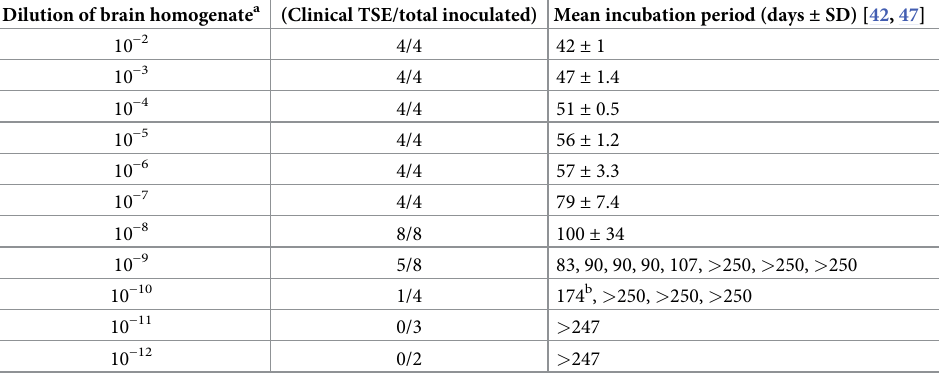
The incubation period to terminal disease was about 174 days at the end-point. An approximate linear regression curve (y = 10.6–0.105x; r = 0.87) was calculated from the mean incubation periods of dilutions 10 − 2 to 10 − 9